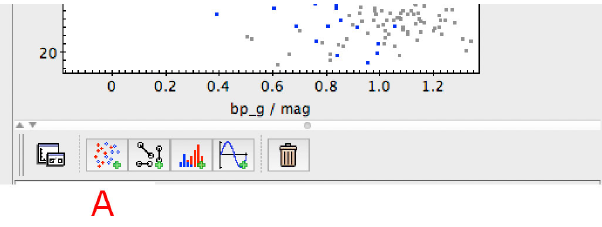
Fig. 72.— Icons in the Plane Plot window, located directly below the displayed plot you click the panel I have marked with a red A, TOPCAT will add another data set (“positional plot control”) to the plot. Click on that data set in the bottom left sub- window, and you will find you can choose which of